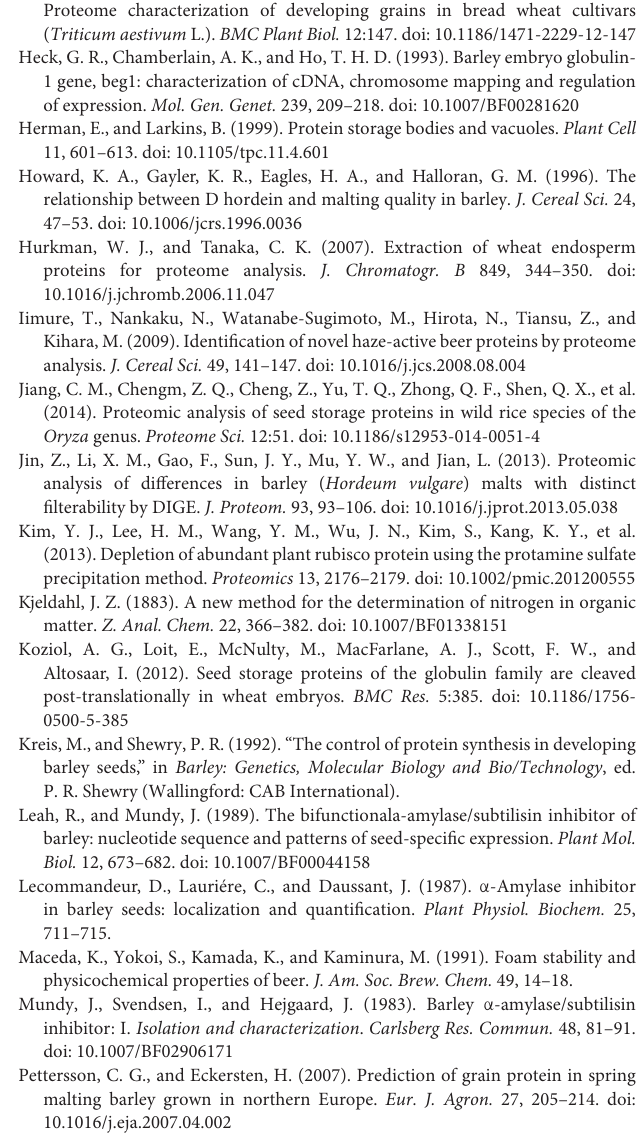
FIGURE S1 | The standard curve for protein concentration determination. FIGURE S2 | All the replicates 2-DE gels in the present study. FIGURE S3 | Expression patterns for differentially expressed protein spots. ∗ p < 0.05, ∗∗ p <